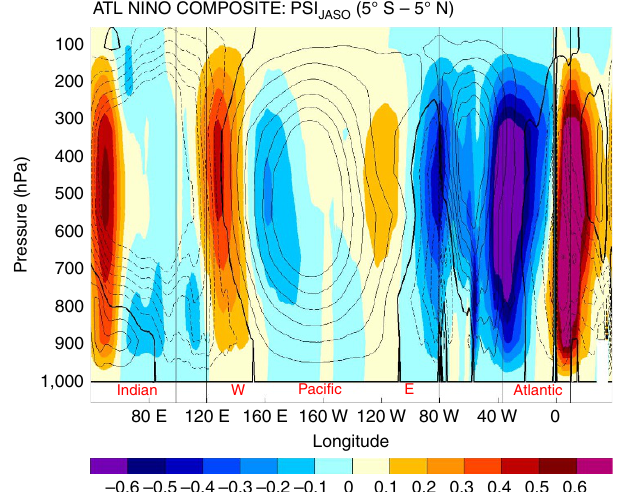
Figure 6 | Composite of Walker circulation anomalies associated with positive Atlantic Nin ˜ o phases. PI climatological zonal stream function of the Walker circulation (contours: 0.2 (cid:3) 10 11 Kgs (cid:2) 1 interval from (cid:2) 1.4 to 1.4 (cid:3) 10 11 Kgs (cid:2) 1 ; 0 line in bold) for the period June to October and its composite anomalies (positive minus negative) associated to Atlantic Nin˜o phase. The zonal stream function composite has been calculated including the anomalies associated to Atlantic Nin˜o and Nin˜a events exceeding 1.5 s.d. (0.69 (cid:2)